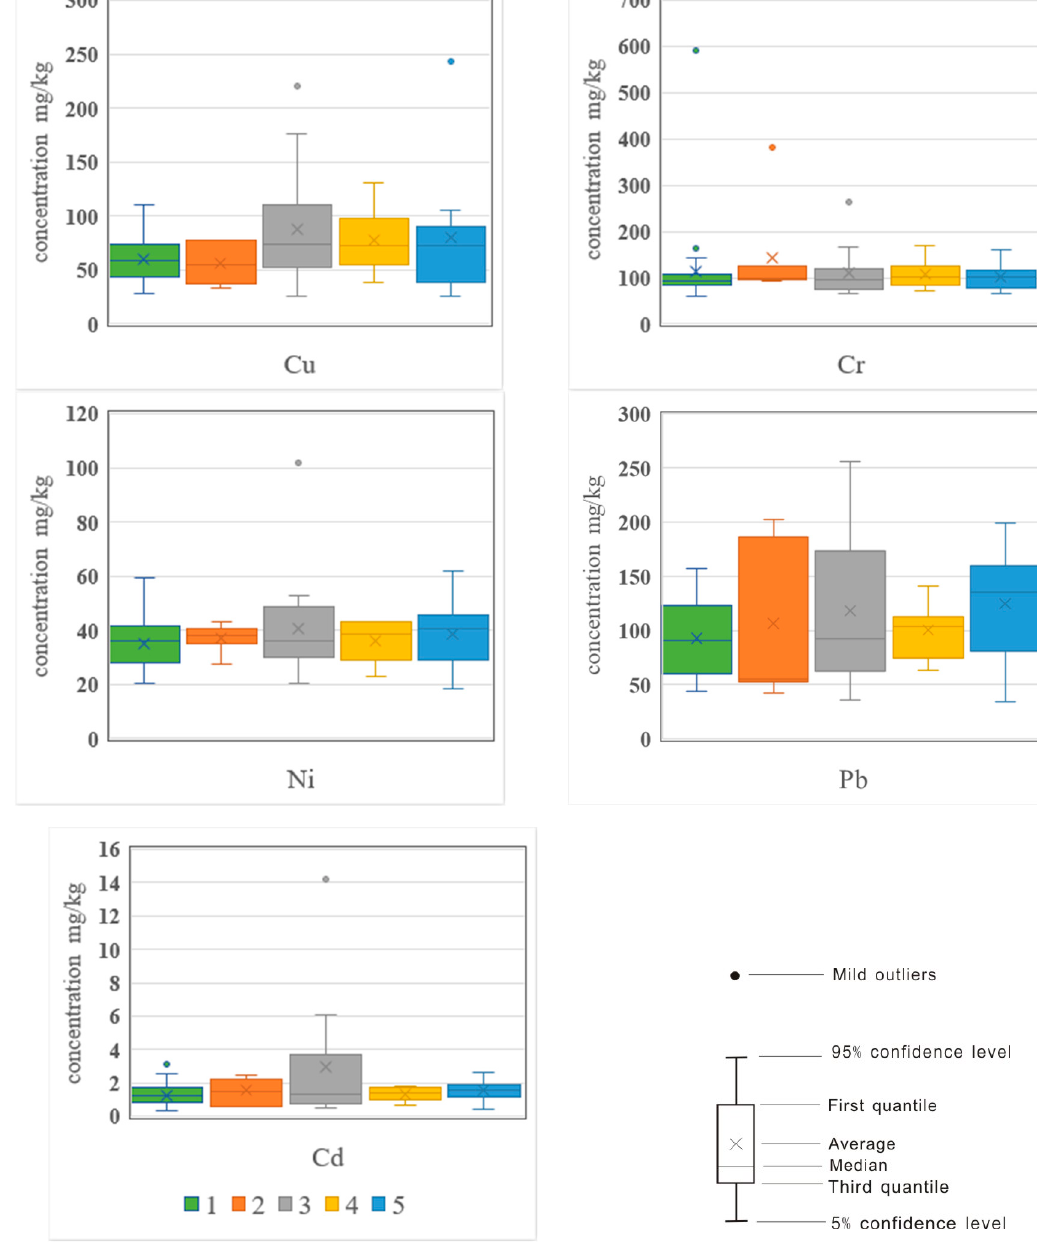
Figure 2. Box plots for functional areas (1, residential area; 2, commercial area; 3, industrial area; 4, office area; 5, traffic